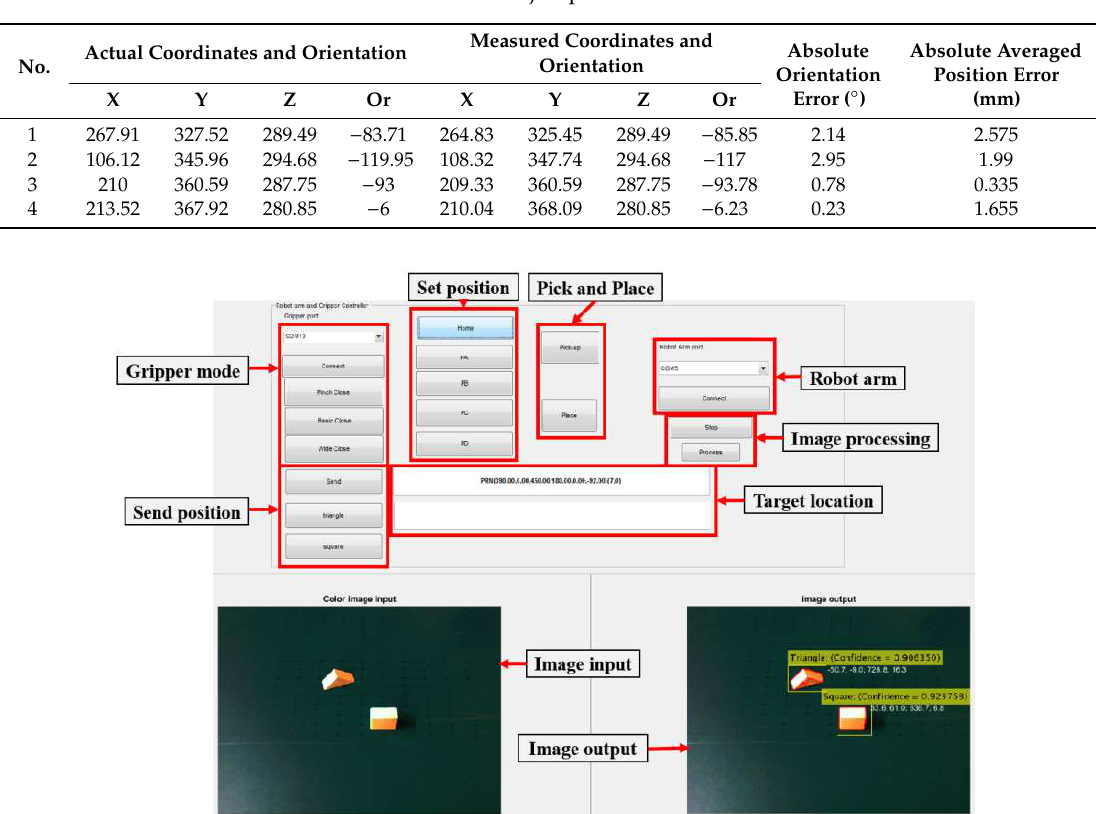
Figure 16. User interface.